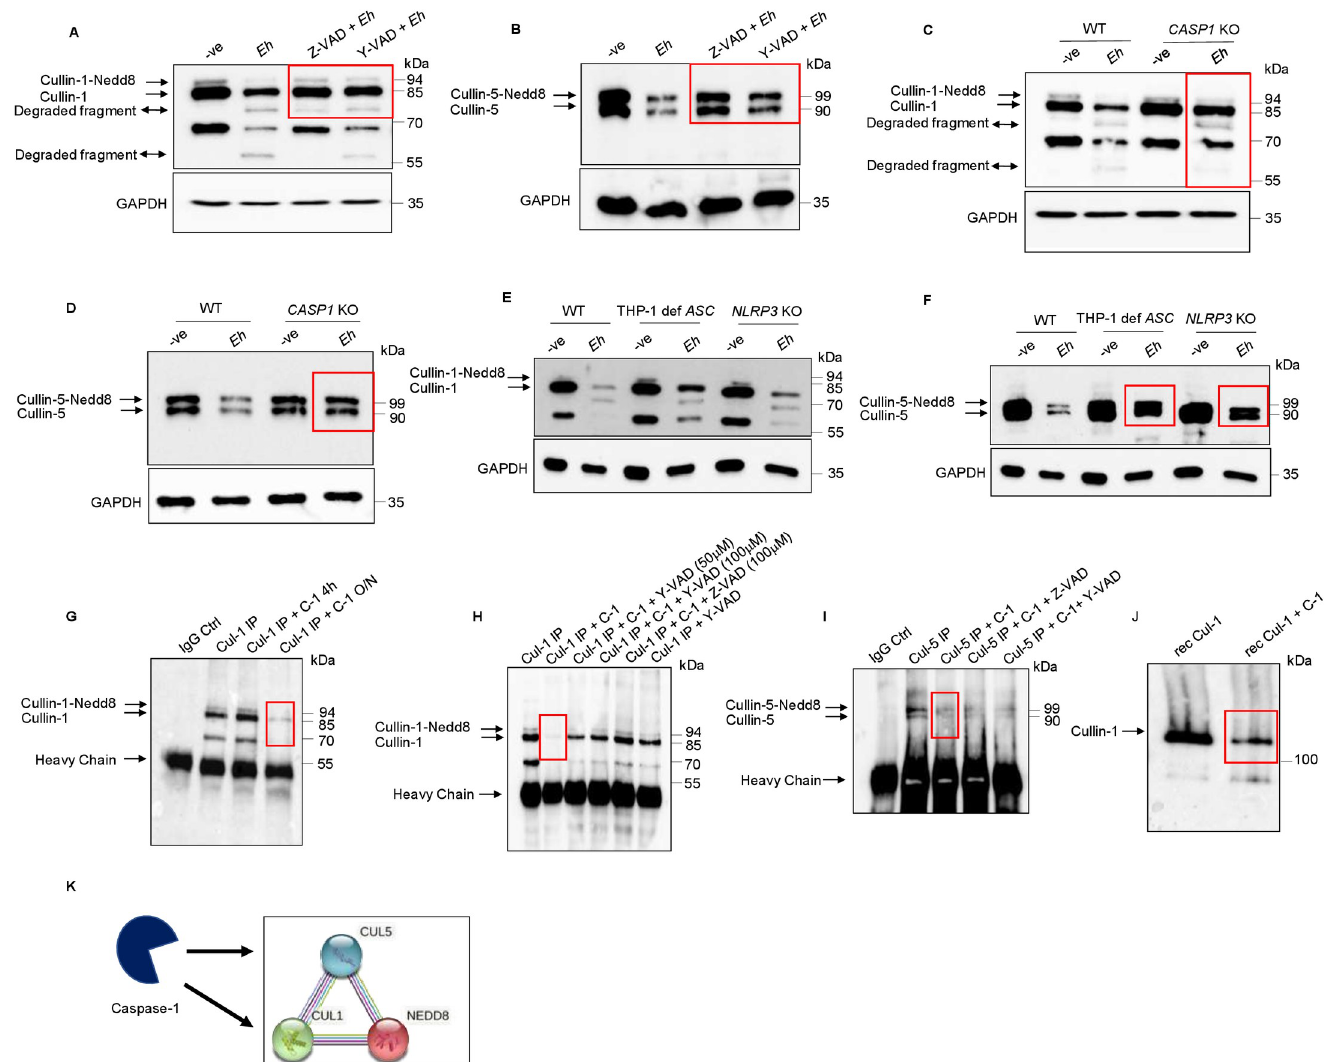
Fig 5. Caspase-1 activation during Eh- macrophage contact degrades cullin-1/5. ( A, B) THP-1 derived macrophages were pre-incubated with the pan-caspase inhibitor Z-VAD-fmk (100 μ M) and caspase-1 specific inhibitor Z-YVAD-fmk (100 μ M) for 1 h followed by stimulation with Eh (10:1 ratio) for 10 min. Cleavage of the cullin-1/5 were assessed by western blot. (C, D) Wild type (WT) THP-1 and CASP1 CRISPR/Cas9-KO macrophages were stimulated with Eh (10:1 ratio) for 10 min. (E, F) WT, THP-1 def ASC and NLRP3 CRISPR/Cas9-KO THP-1 macrophages were stimulated with Eh (10:1 ratio) for 10 min. After incubation, cells were washed and lysed. Equal amount of protein was loaded on to the SDS-PAGE (7.5%) and immunoblotted with anti-cullin-1 ( Panel: A, C, and E ) , anti-cullin-5 (Panel: B, D and F) and anti-GAPDH antibody. (G) Cullin-1 was immunoprecipitated (Cul-1 IP) using anti cullin-1 antibody and post immunoprecipitation it was incubated with recombinant caspase-1 (C-1) for 4h or overnight (O/N). (H) Immunoprecipitated cullin-1 was incubated with recombinant caspase-1 or with Y-VAD-fmk (50 μ M or 100 μ M) or Z-VAD-fmk (100 μ M). (I) Immunoprecipitated cullin-5 was incubated with recombinant caspase-1 or with Z-VAD-fmk (100 μ M) or Y-VAD-fmk (100 μ M). (J) Recombinant cullin-1 (rec Cul-1) was incubated with recombinant caspase-1 overnight at 37˚ and was immunoblotted with anti-cullin-1 antibody. Note, recombinant cullin-1 (rec Cul-1) has a molecular weight of ~118 kDa due to the N-terminus GST tag (~28kDa). The highlighted boxed areas in the figures show point of interest for cullin-1/5 as described in text. (K) Protein-protein interaction using STRING v11 showed direct interaction between cullin-1, cullin- 5 and Nedd8 demonstrated that cullin-1/5 are novel substrates for caspase-1. Data (A, B, C and D) are representative of three independent experiments while data (E, F, G, I, and J) are representative of two independent